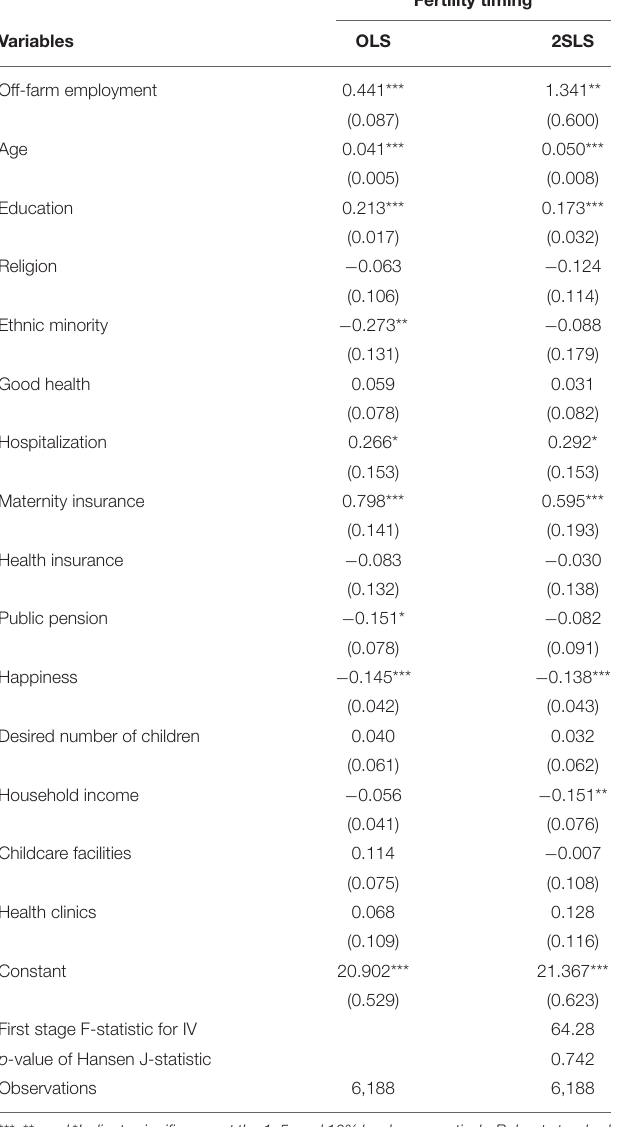
Fertility timing